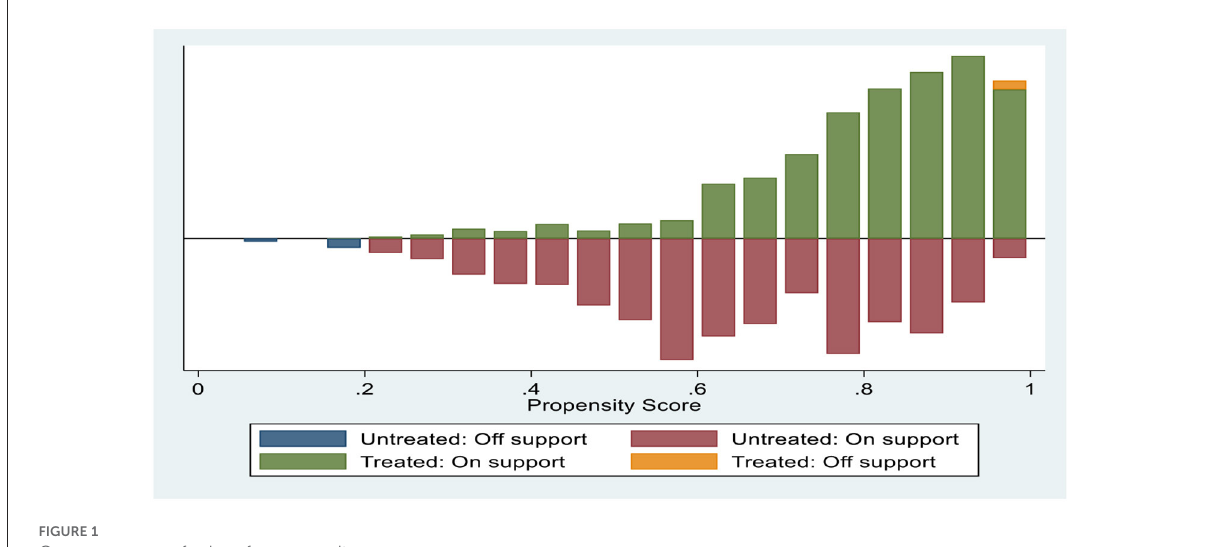
FIGURE1 Common range of values for propensity score.